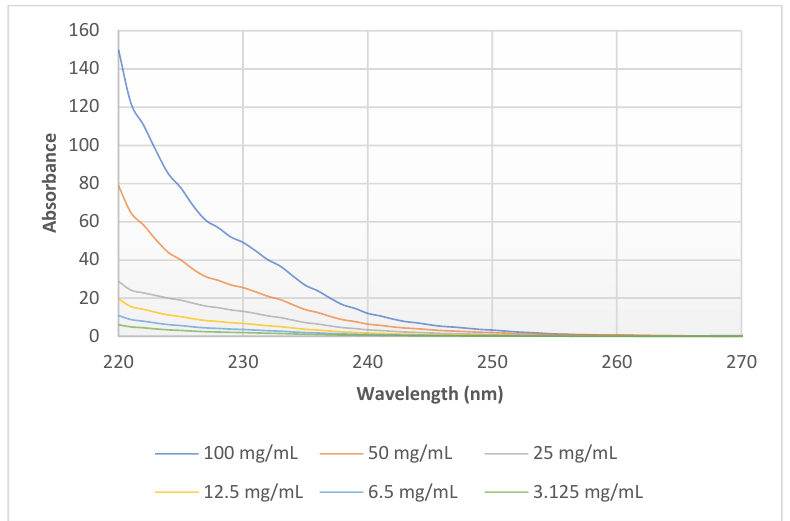
Figure 4. Absorbance spectra of 25 kPEI dilution series (100–50–25–12.5–6.25–3.125 mg/mL) in DW. UV-Vis analysis program was applied (λ = 220–750 nm) with 3 µL drop of solution after calibration with DW at room temperature (23°C).